Question: Briefly state, in one sentence, what is plotted here.
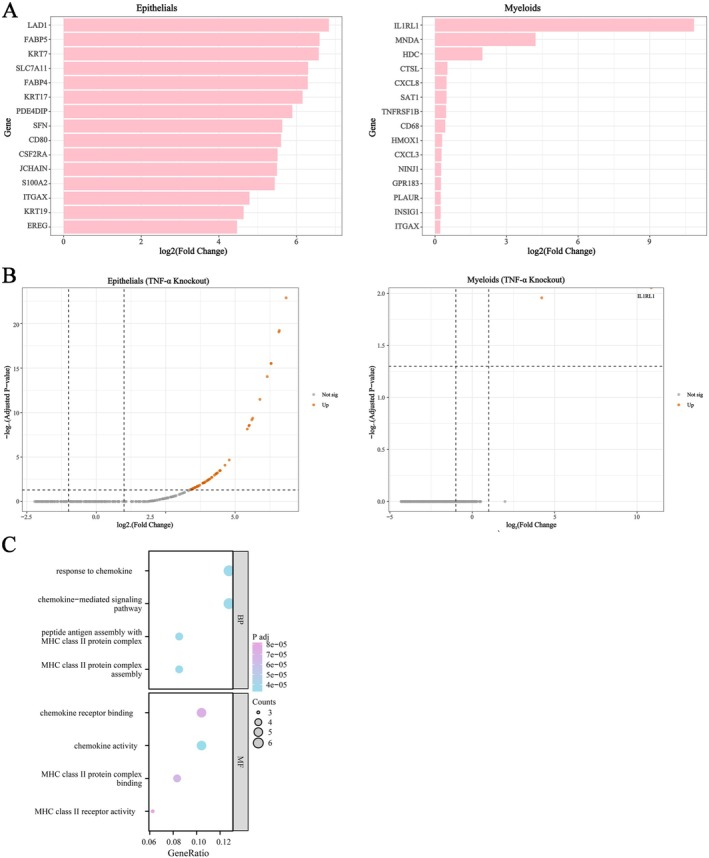
Answer: Virtual gene knockout validates the pro‐inflammatory function of TNF in epithelial and myeloid cells of IC/BPS. (A) Heatmaps depicting transcriptomic alterations in epithelial and myeloid cells following virtual TNF knockout, highlighting the downregulation of pro‐inflammatory gene programs. (B) Volcano plots of DEGs after virtual TNF knockout in epithelial and myeloid cells, quantifying the degree of inflammatory gene suppression. (C) GO enrichment analysis of dysregulated genes following epithelial TNF knockout, demonstrating significant attenuation of chemokine‐mediated signaling (BP) and immune receptor activity (MF) pathways.